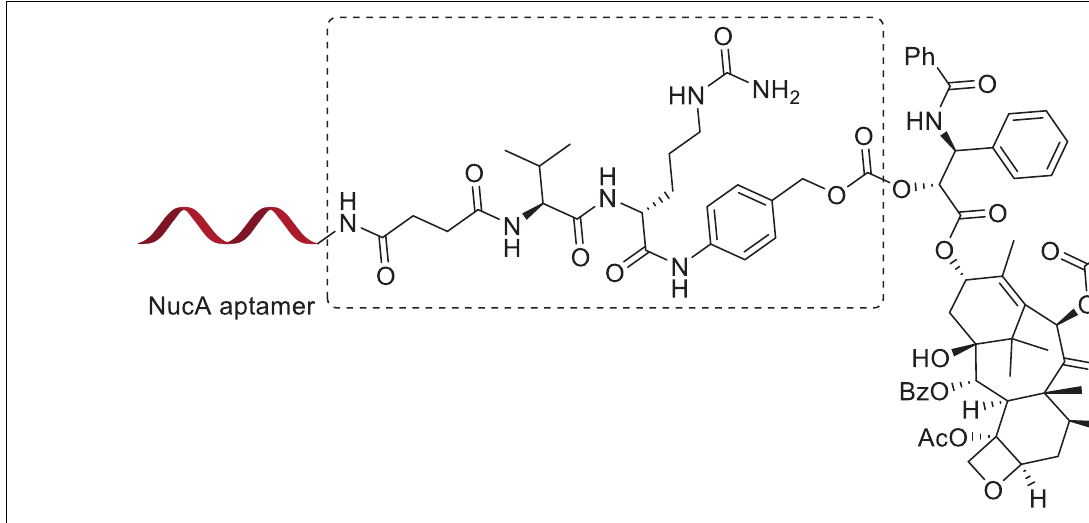
FIGURE 9 | The structure of the NucA–PTX conjugate.